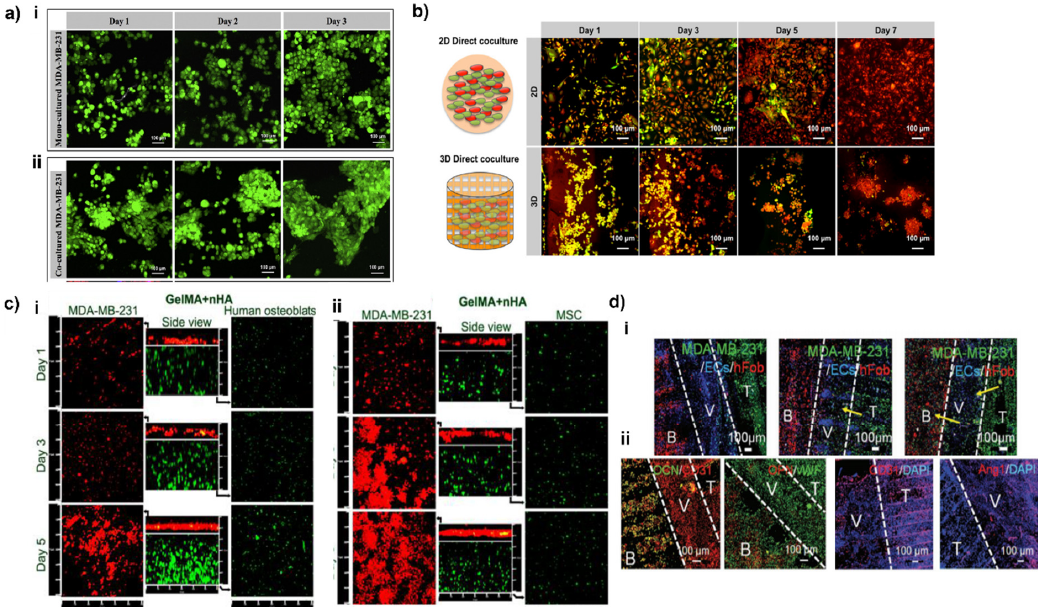
Figure 4. Effect of tumor-healthy cell interactions in co-culture systems and in 3D vs. 2D models. ( a ) Morphology of breast cancer cells cultured alone or with MSCs. (i) Confocal images of MDA-MB-231 alone, and (ii) in co-culture with MSCs; green fluorescence represents Cell Tracker Green™ stained breast cancer cells. Reproduced with the permission of © 2015 Elsevier Inc. All rights reserved [146]. ( b ) Enhanced spheroid formation by direct co-culture of hFOB and MDA-MB-231 cells on the 3D matrix in comparison to monolayer culture. hFOB and MDA-MB-231 were pre-stained with cell tracker green and orange, respectively. Reproduced with the permission of © IOP Publishing. All rights reserved [170]. ( c ) Confocal micrographs of osteoblasts/breast cancer cells (i) and MSCSs/breast cancer cells (ii) co-cultured in the 3D-bioprinted matrix after 1, 3, and 5 days. The middle columns represent the cross-sectional views. Osteoblasts and breast cancer cells were stained by Cell Tracker Green CMFDA dye (green) and Orange CMTMR dye (red), respectively. Reproduced with the permission of © 2016, American Chemical Society [147]. ( d ) Development of MDA-MB-231 cells metastasis and colonization toward bone over 14 d of the culture period. Cell tracker imaging was conducted to monitor the BrCa invasive process, including breast cancer growth, transendothelial migration, and colonization. The yellow arrows indicate the migration of invasive breast cancer cells. (i) Immunofluorescent images of hFOB and MDA-MB-231 cells in a vascular environment with DAPI staining after 14 d of culture. CD31 and vWF staining were used to identify both EC and breast cancer cells. (ii) Osteogenesis of hFOB was characterized by OCN and OPN staining. Combining CD31 and Ang1 was used to distinguish the breast cancer cells and endothelial cells. B: bone tissue, V: vessel, T: tumor tissue. Reproduced with the permission of Wiley-VCH GmbH [41].